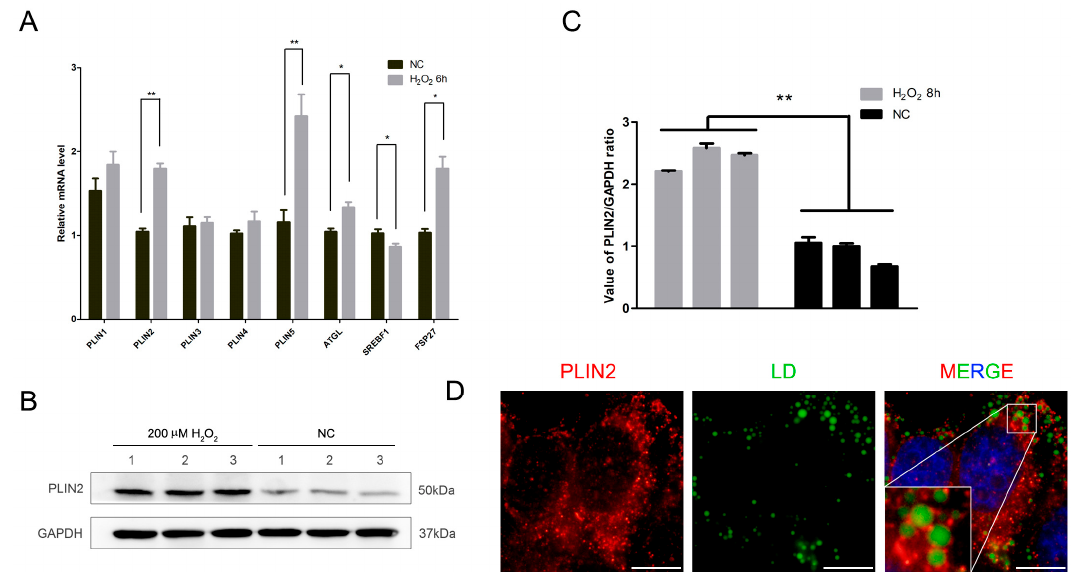
Figure 2. Hydrogen peroxide promotes the expression of PLIN2 (perilipin2). ( A ) Detection of lipid droplet-related gene mRNA expression levels after hydrogen peroxide treatment. *, p < 0.05; **, p < 0.01. ( B ) Western blot analysis of PLIN2 protein expression levels. ( C ) Density analysis of PLIN2 protein expression levels. **, p < 0.01. ( D ) Cellular immunofluorescence detects the localization of PLIN2 in cells. Scale bar = 10 μ m.